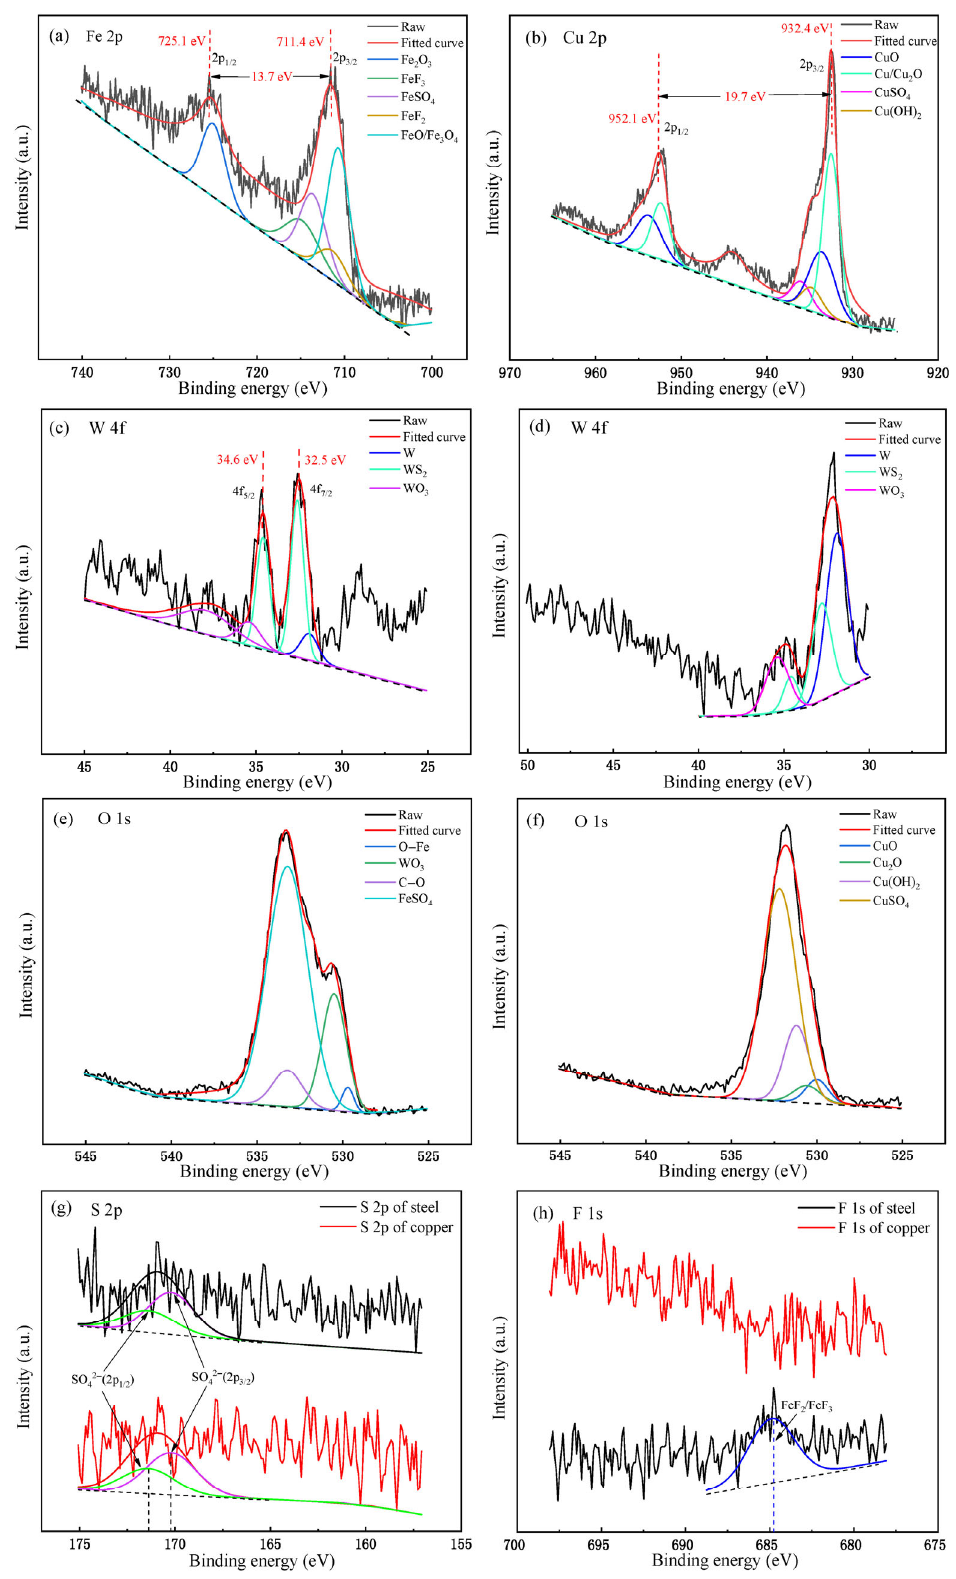
Fig. 10 XPS spectra of elements on wear surface of plate lubricated by LCG + 2% PW10: (a) Fe 2p, (b) Cu 2p, W 4f for (c) steel plate and (d) copper plate, O 1s for (e) steel plate and (f) copper plate, (g) S 2p, and (h) F